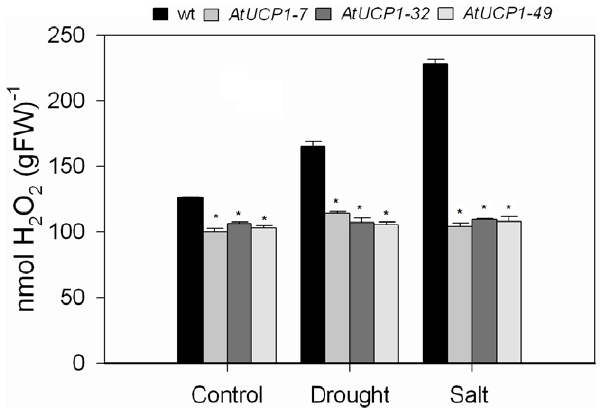
Figure 6. Quantification of hydrogen peroxide in leaves of wild-type (WT) and AtUCP1 transgenic tobacco plants. Thirty- day-old plants were exposed for 10 days to 200 mM mannitol or 175 mM NaCl. In the controls, plants were irrigated with water. The bar represents the mean ( 6 S.D.) from three independent experiments (n=5). * indicates significant differences relative to the control at P , 0.0001. gFW: grams of fresh weight.